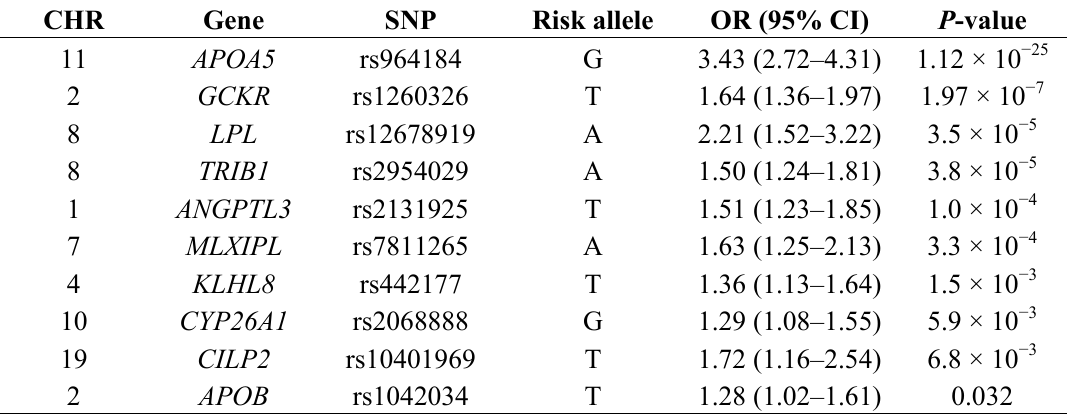
Table 4. Common DNA polymorphisms associated with hypertriglyceridemia.